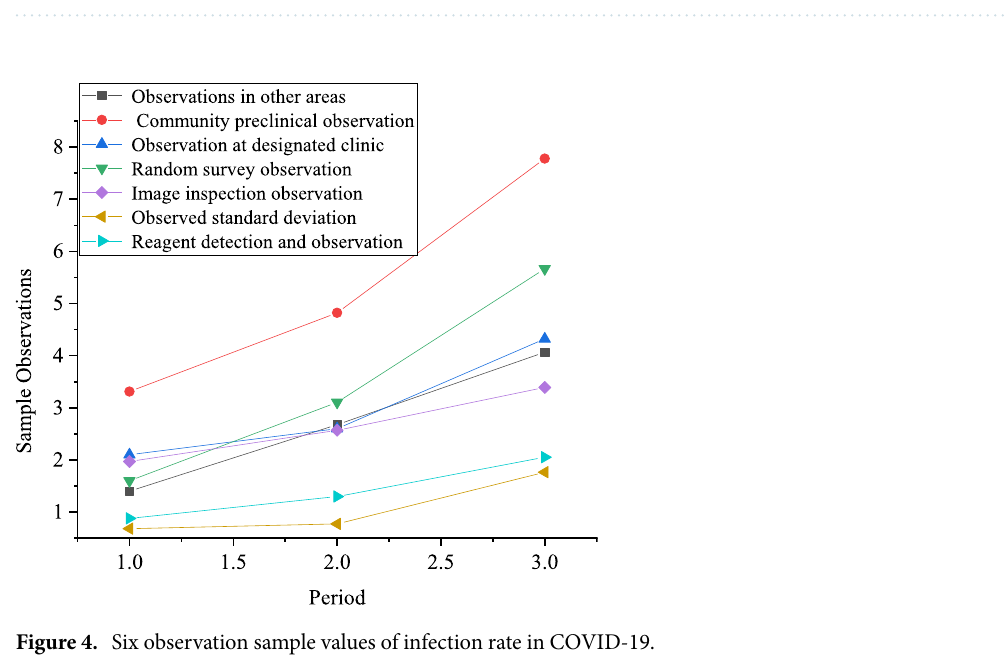
Table 2. Values of the matrixes of normalized schemes.